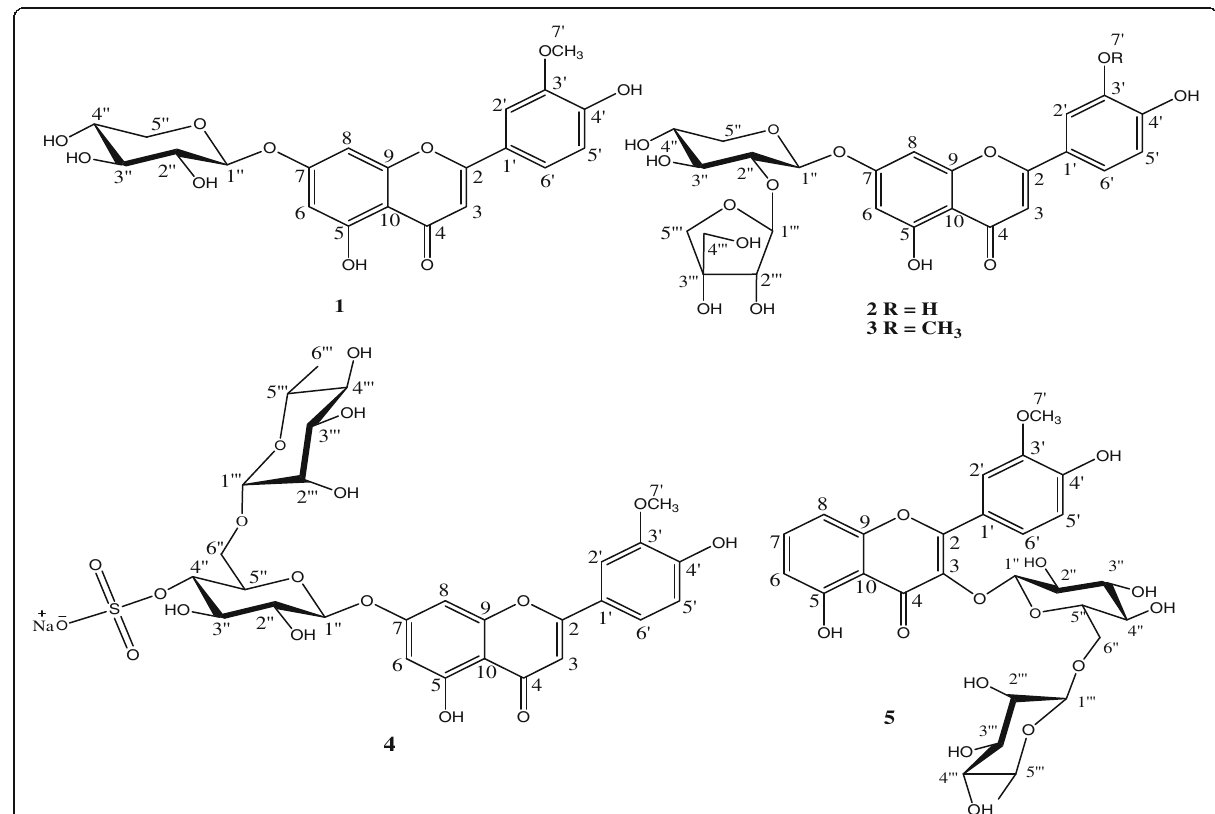
Fig. 1 Chemical structures of flavonoids ( 1 – 5 ) isolated from n -BuOH extract of aerial parts of G. grandulosum Turill. 1 :chrysoeriol-7- O - β -D-xyloside; 2: luteolin-7- O - β -D-apiofuranosyl-(1 → 2)- β -D-xylopyranoside; 3 : chrysoeriol-7- O - β -D-apiofuranosyl-(1 → 2)- β -D-xylopyranoside; 4 : chrysoeriol-7- O - α - L-rhamnopyranosyl-(1 → 6)- β -D-(4"-hydrogenosulfate) glucopyranoside ; 5: Isorhamnetin-3- O - α -L-rhamnopyranosyl-(1 → 6)- β